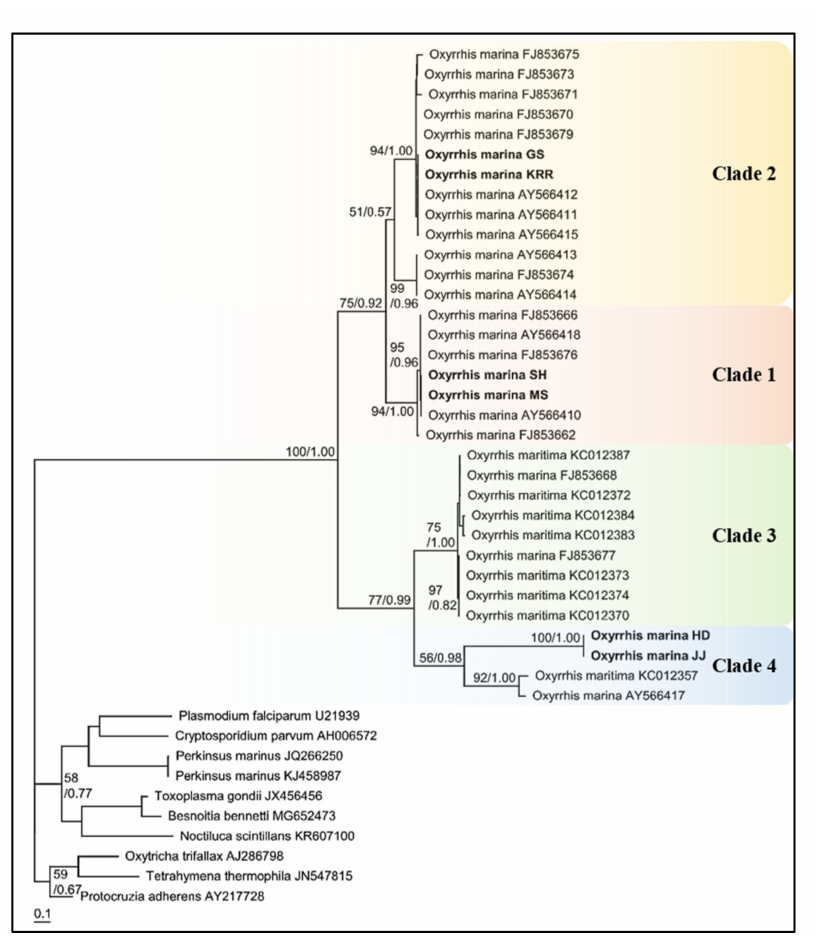
Figure 5. Consensus Maximum likelihood tree of nuclear internal transcribed spacer 1 (ITS1)-5.8S- ITS2 sequences for 6 strains of Oxyrrhis spp. with other dinoflagellates and outgroup, Perkinsus sp., Ciliates, and Apicomplexans. The branch lengths are proportional to the number of base changes. The numbers near the branches indicate the Bayesian posterior probability ( left ) and maximum likelihood bootstrap values ( right ). Posterior probabilities ≥ 0.5 are